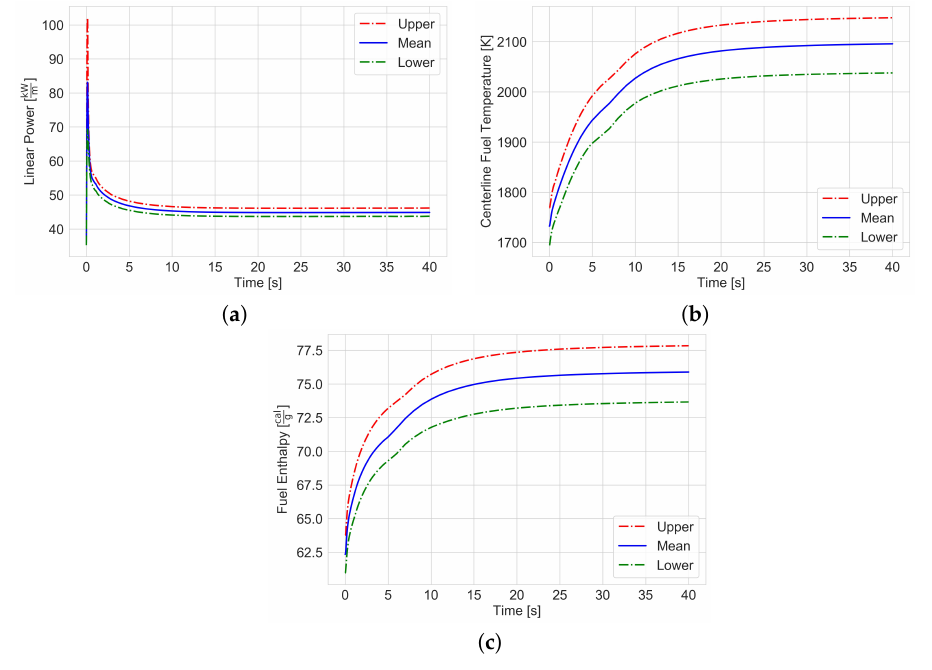
Figure 34. Temporal evolution of the ( a ) P max